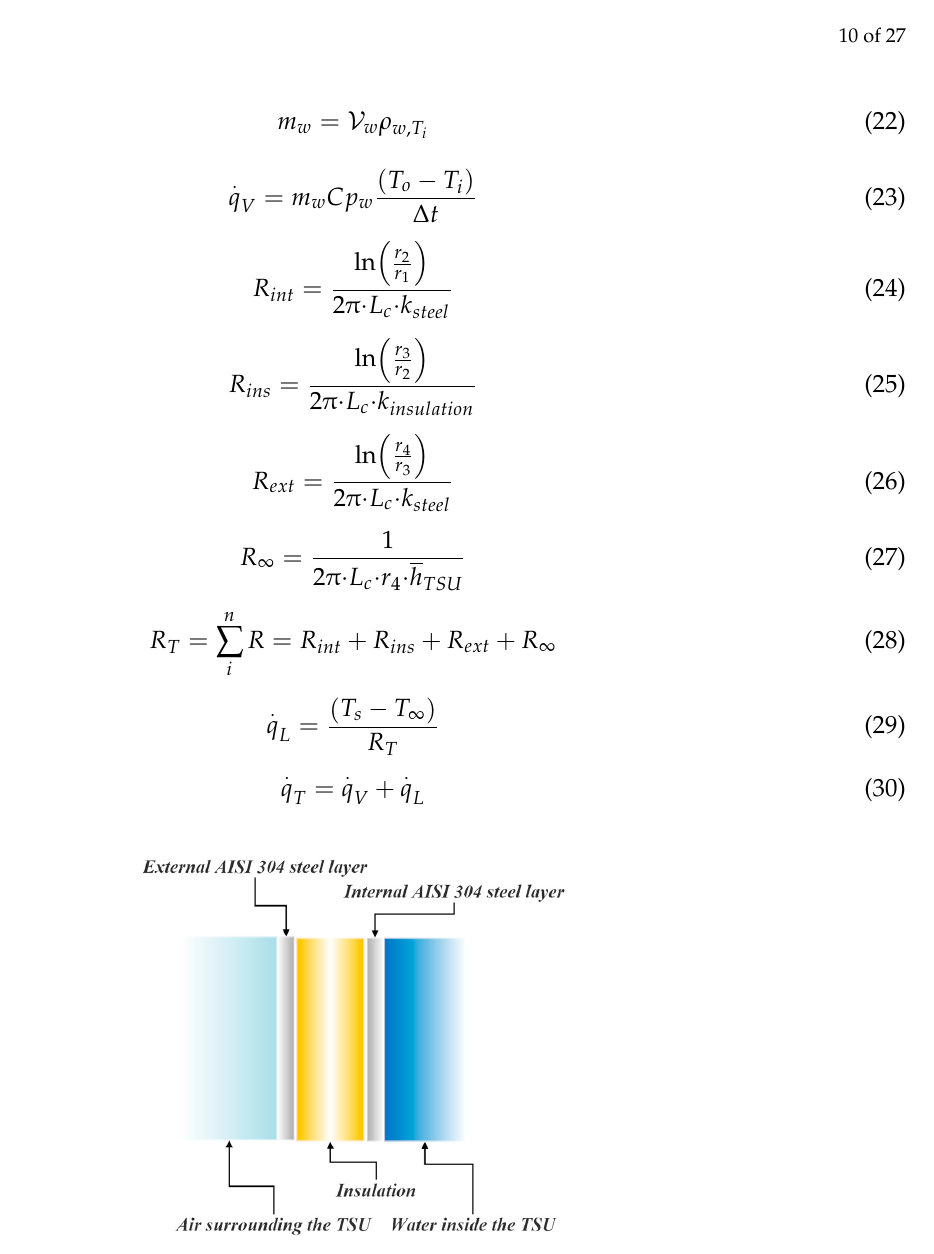
Figure 4. Radial cross-section of the TSU.